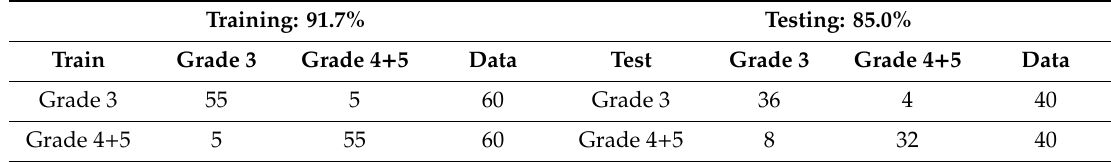
Table 3. Confusion matrix of SVM binary classification—Grade 3 vs. Grade 4, 5.